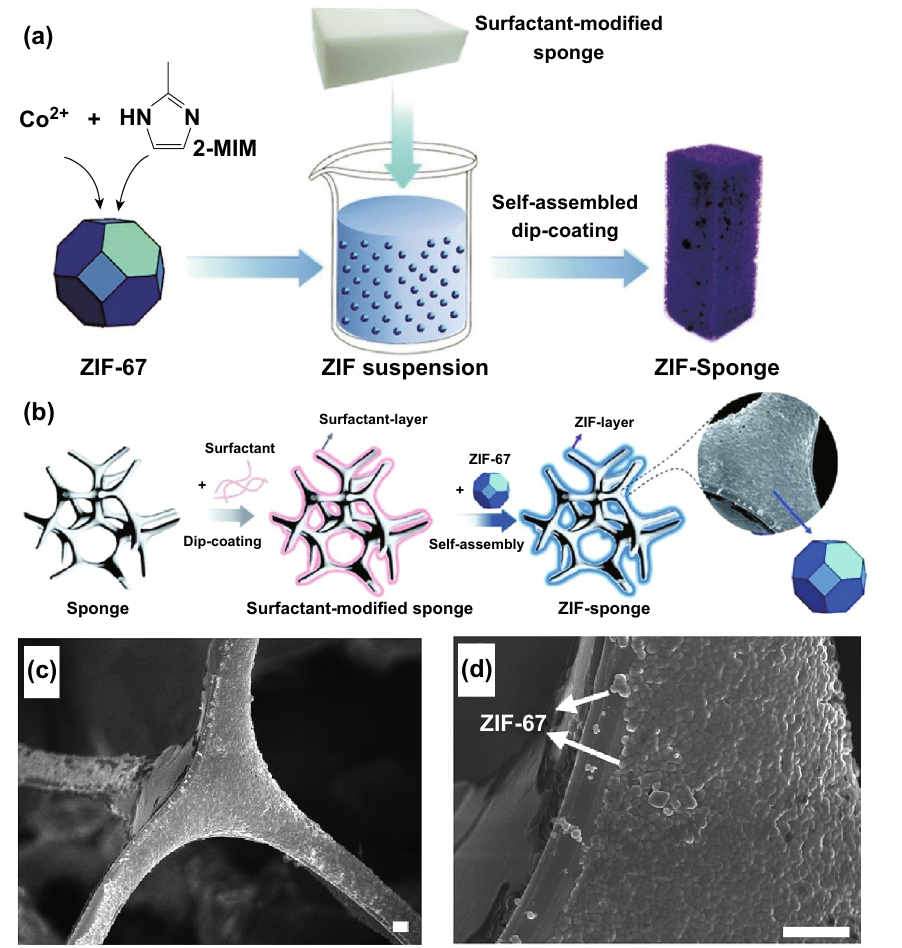
Fig. 10 Schematic illustrations showing the preparation of ZIF–sponge, showing a surfactant-assisted dip-coating self-assembling process and b surface modification of the sponge skeleton first with a surfactant and then ZIF-67. c, d SEM images of ZIF–sponge prepared with the assistance of SDBS under different magnifications (the scale bar is 2 µm), showing ZIF nanocrystals were dip-coated on the surface of melamine sponge. Reprinted with permission from Ref. [71]. Copyright 2015 Royal Society of